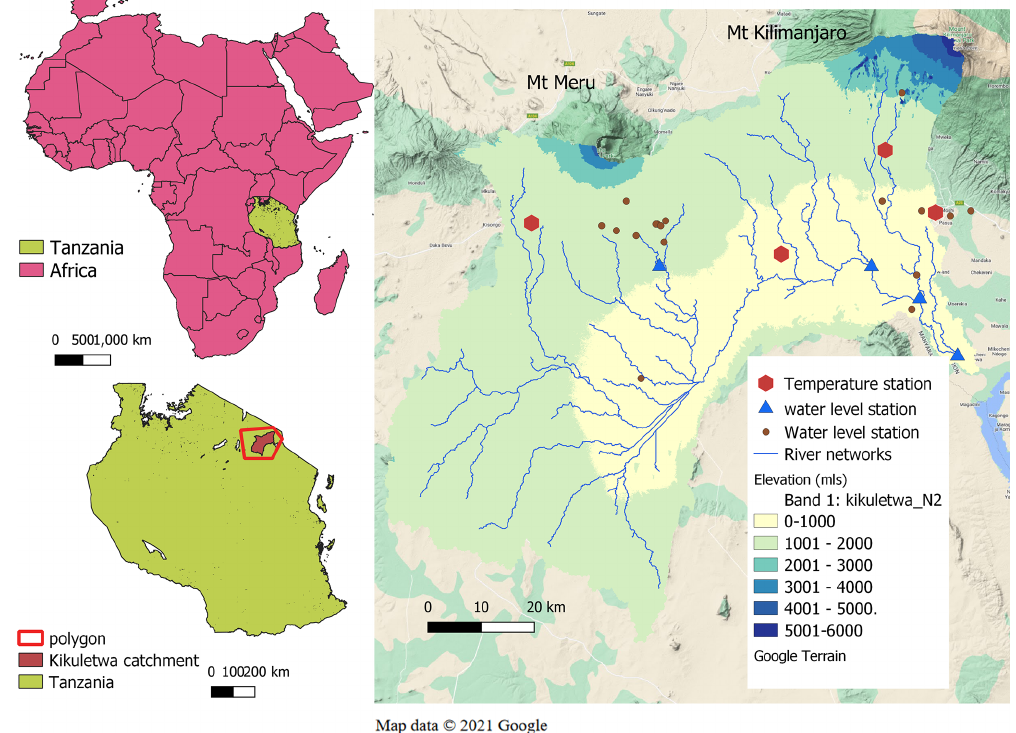
Figure 1. The location of the Kikuletwa catchment in Africa (inset map). The catchment map shows the river networks and the location of groundwater level, rainfall, and temperature station in and around the catchment.